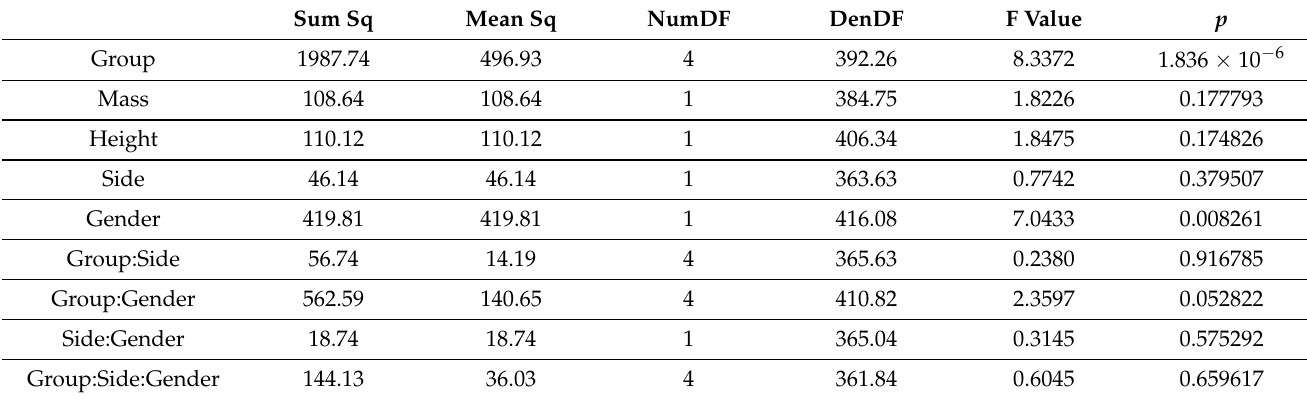
Table 4. Type III analysis of variance table with Satterthwaite’s method for MSE .